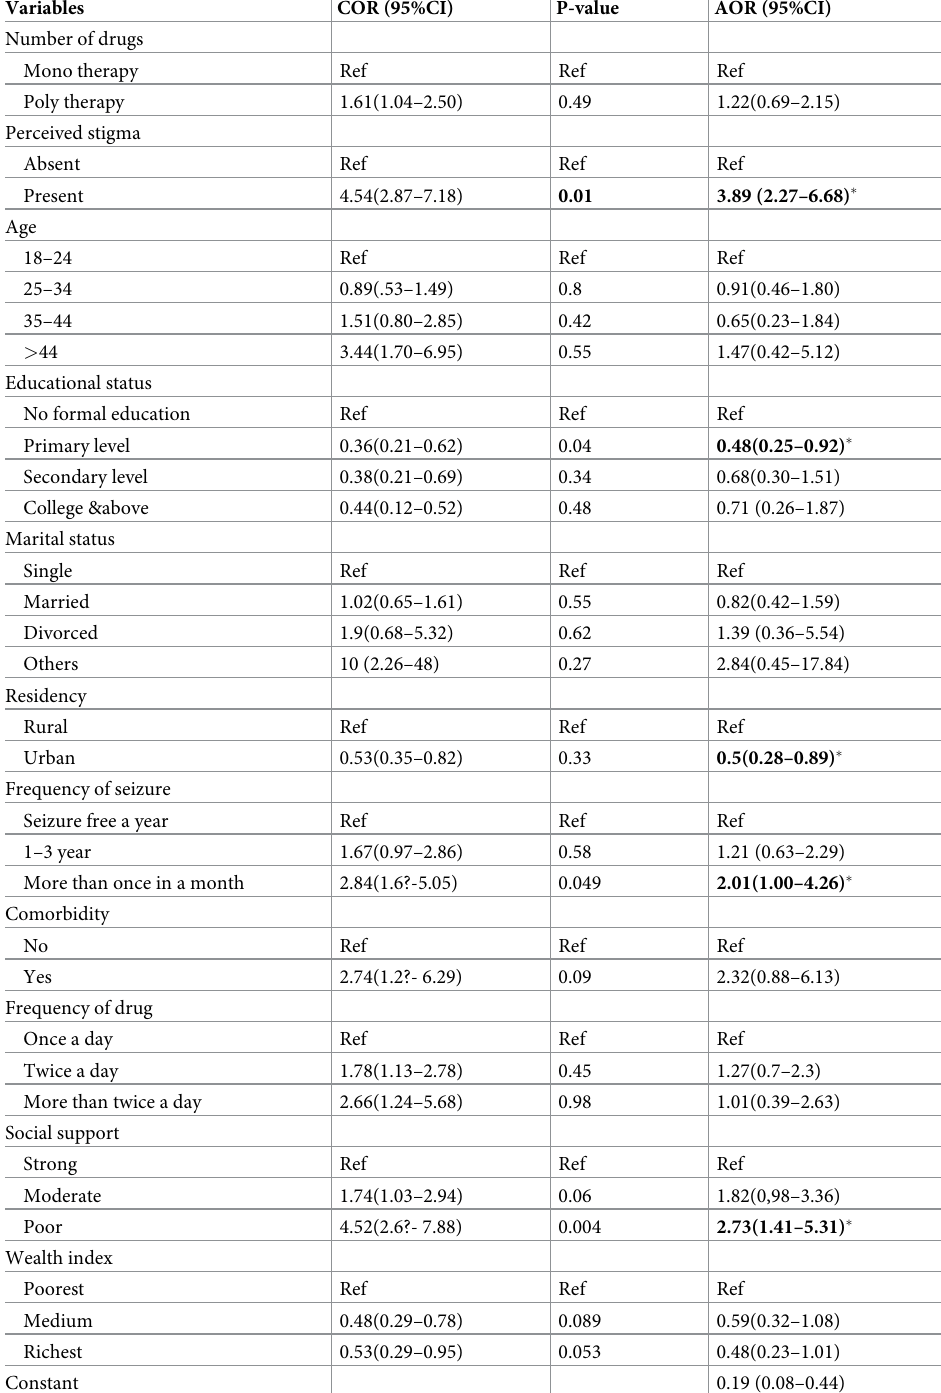
Table 3. Multivariable logistic regression analysis of potential factors associated with depression at UoGCSH 2019, (n =